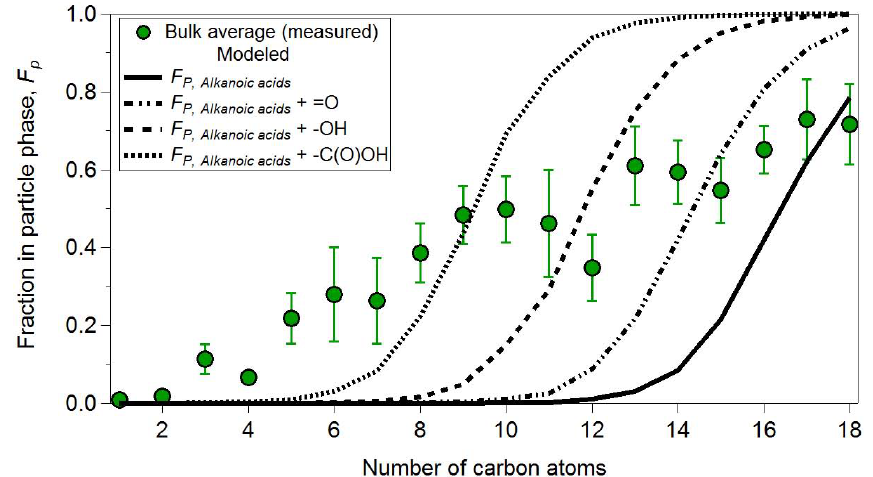
Fig. 4. Campaign average of F p for bulk-averaged data binned into carbon number bins. Also shown is F p calculated from gas–particle partitioning theory for (right to left) alkanoic acids and alkanoic acids with the addition of a carbonyl, hydroxyl or a carboxyl group. Error bars represent measurement precision and variability due to ambient temperature and OA